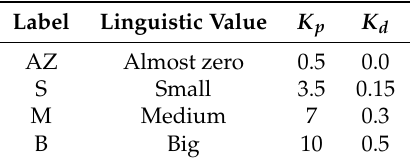
Table 2. Linguistic values for K p and K d